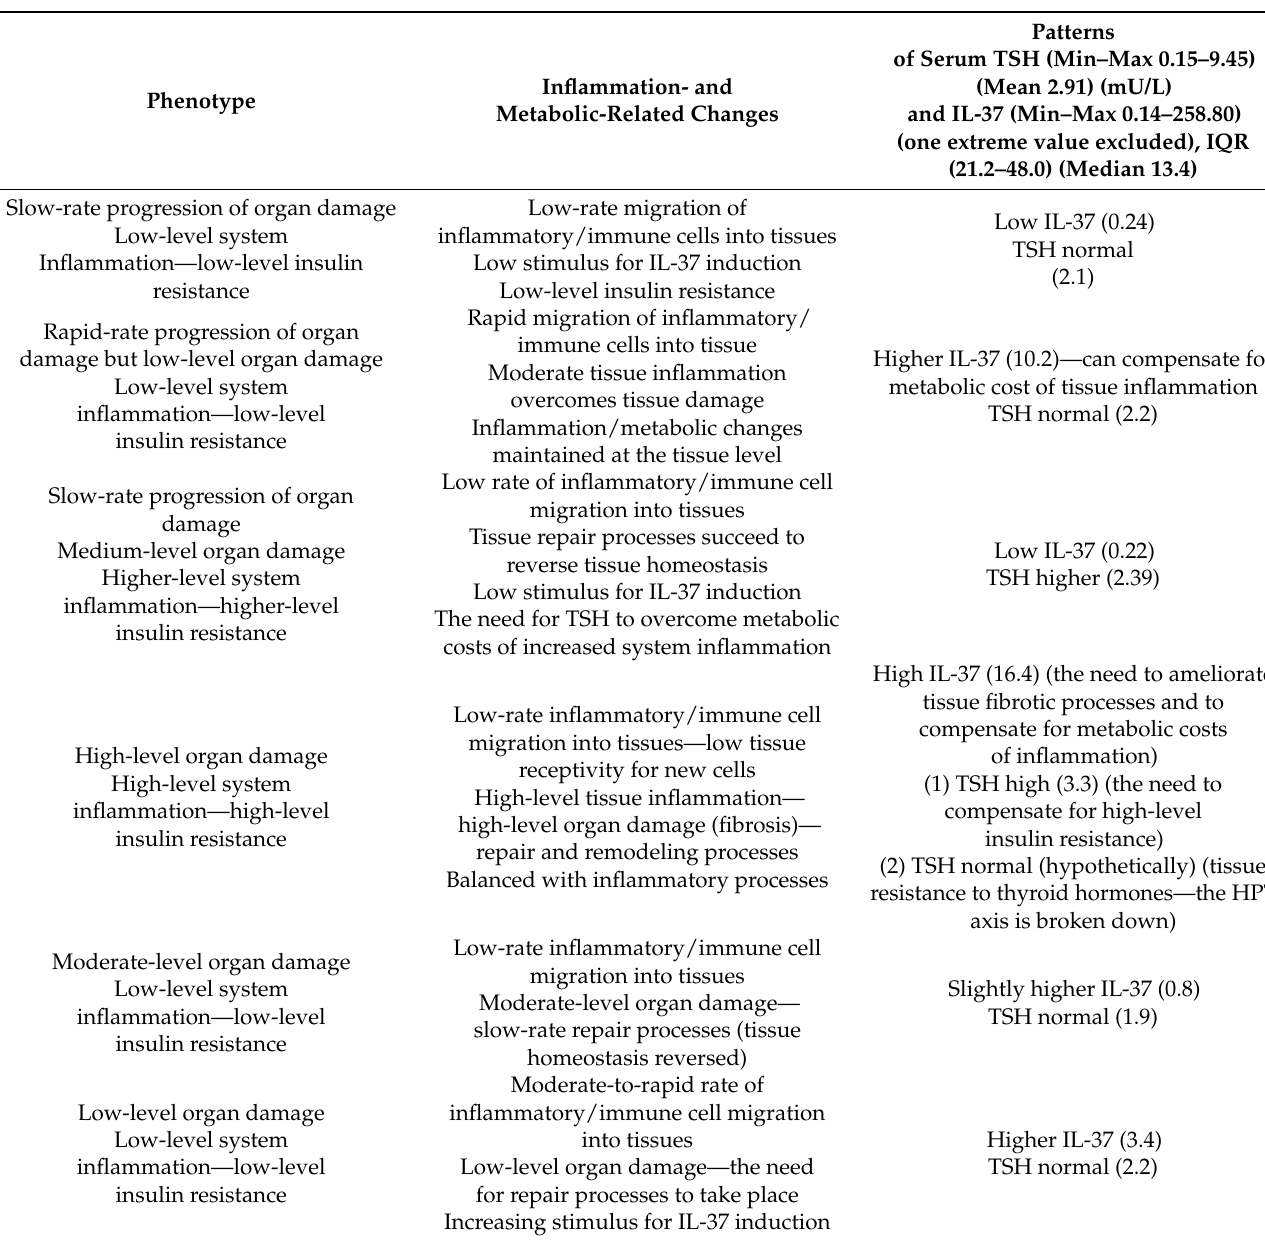
Table 1. The patterns of serum TSH and IL-37 levels in revealing patterns of target organ-related inflammation and system-level inflammation in age-related metabolic and vascular conditions, according to Ref.